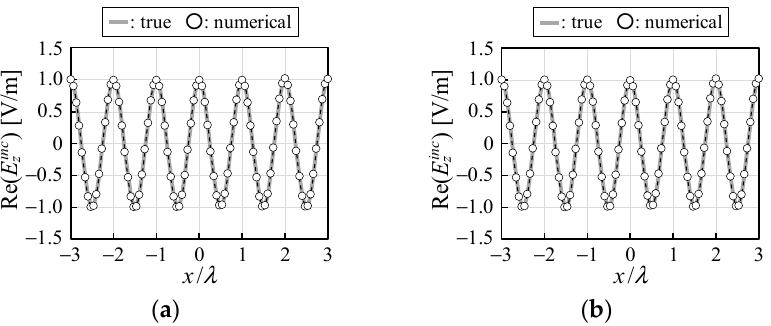
Figure 8. Extraction results of incident field in Ω i ( M = 200): ( a ) square target and ( b ) L-shape target.